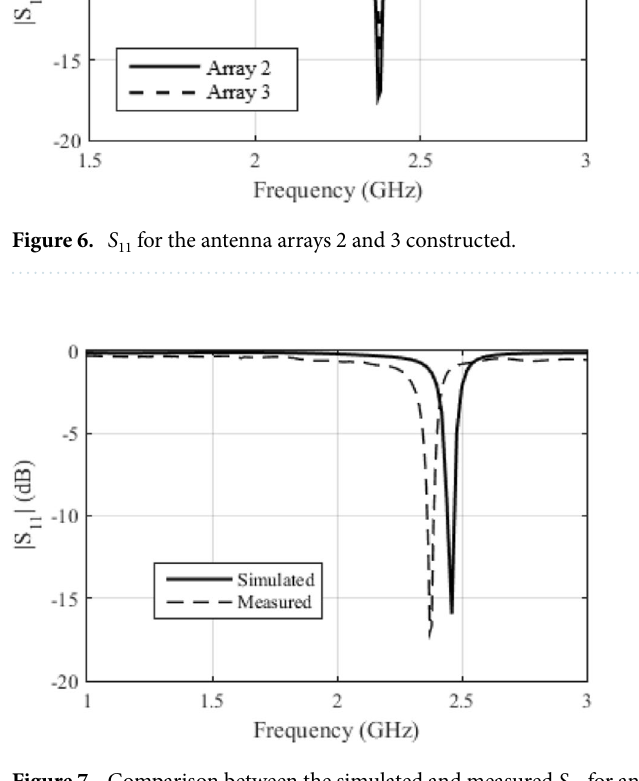
Figure 7. Comparison between the simulated and measured S 11 for antenna array